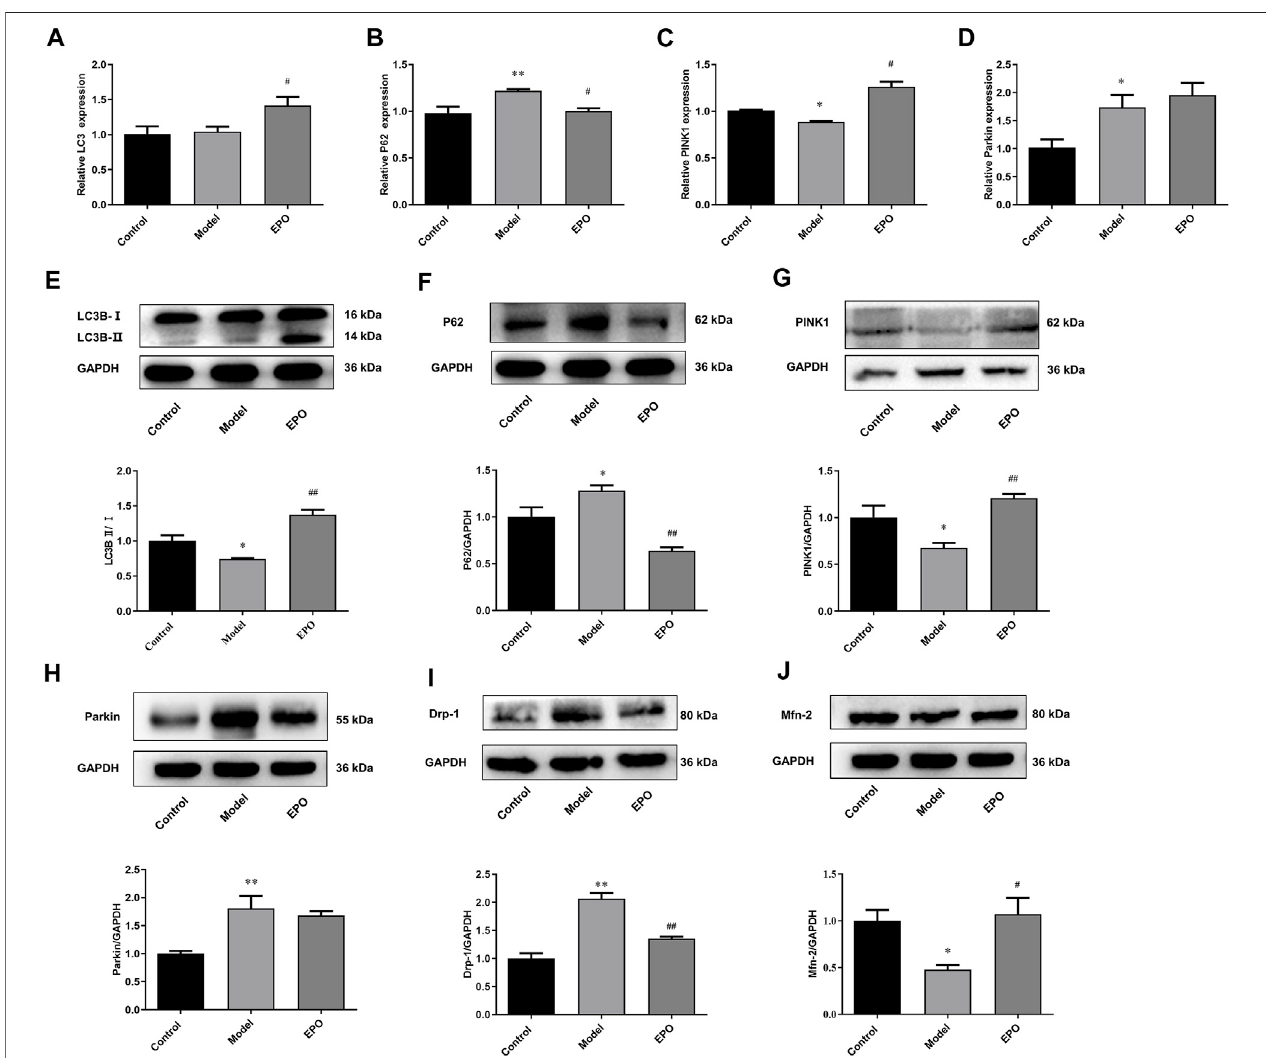
FIGURE6| EPOactivatedPINK1/Parkin-mediatedmitophagyinkidneytissuesofDNmice.Thechangesof (A) LC3mRNAexpression, (B) P62mRNAexpression, (C) PINK1mRNAexpression, (D) ParkinmRNAexpression, (E) theratioofLC3B- Ⅱ /LC3B- Ⅰ , (F) P62proteinexpression, (G) PINK1proteinexpression, (H) Parkinprotein expression, (I) Drp-1 protein expression, (J) Mfn-2 protein expression. Values are presented as mean ± SEM, n = 3. * p < 0.05, ** p < 0.01 vs. Control group; # p < 0.05, ## p < 0.01 vs. Model group.